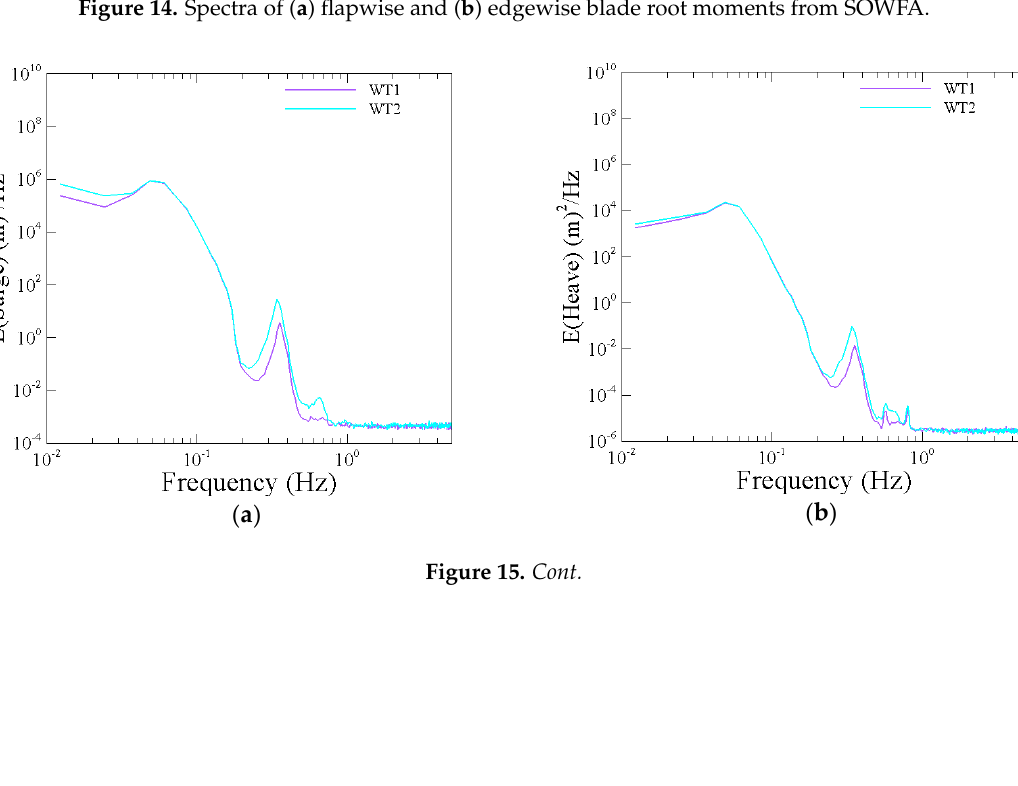
Figure 14. Spectra of ( a ) flapwise and ( b ) edgewise blade root moments from SOWFA.